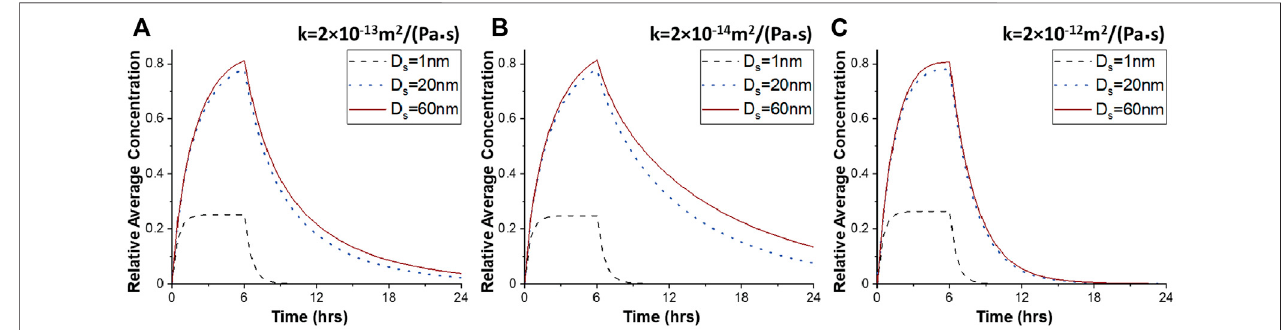
FIGURE 3 | Average drug concentration as a function of the time for different hydraulic conductivities of the tumor interstitial space. Average drug concentration in tumor tissue as a function of time for different diameters of therapeutic agents, D s , for 100 nm pore diameter of vascular walls, and for different values of the hydraulic conductivity of the tumor interstitial space, k : (A) 2 × 10 − 13 m 2 /(Pa s), (B) 2 × 10 − 14 m 2 /(Pa s), and (C) 2 × 10 − 12 m 2 /(Pa s). Drug concentration is normalized by division with the reference value entering the